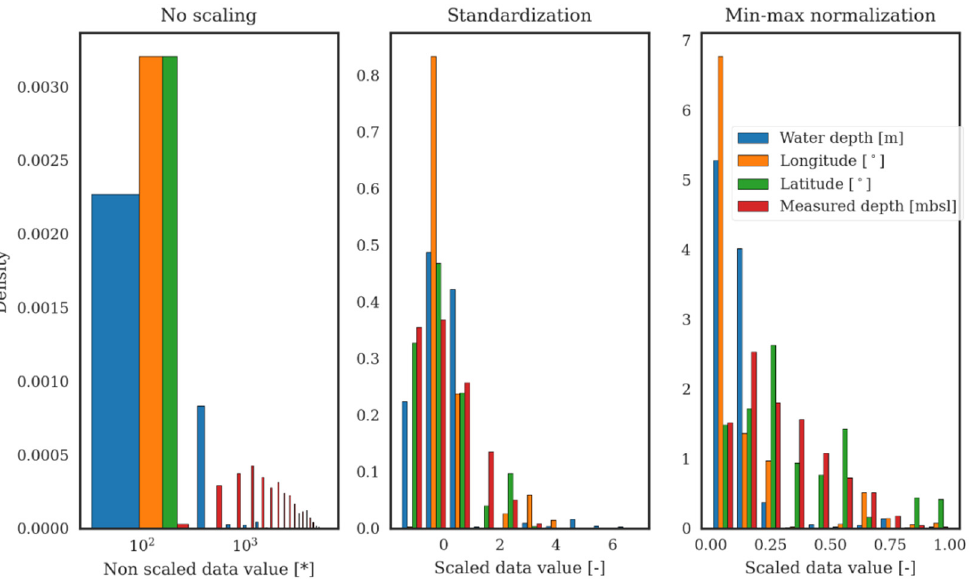
Figure 5. Non-scaled training dataset ( left ) and scaled training dataset with standardization ( center ) and min-max normalization ( right ); the units of the horizontal scale can be found in the legend.